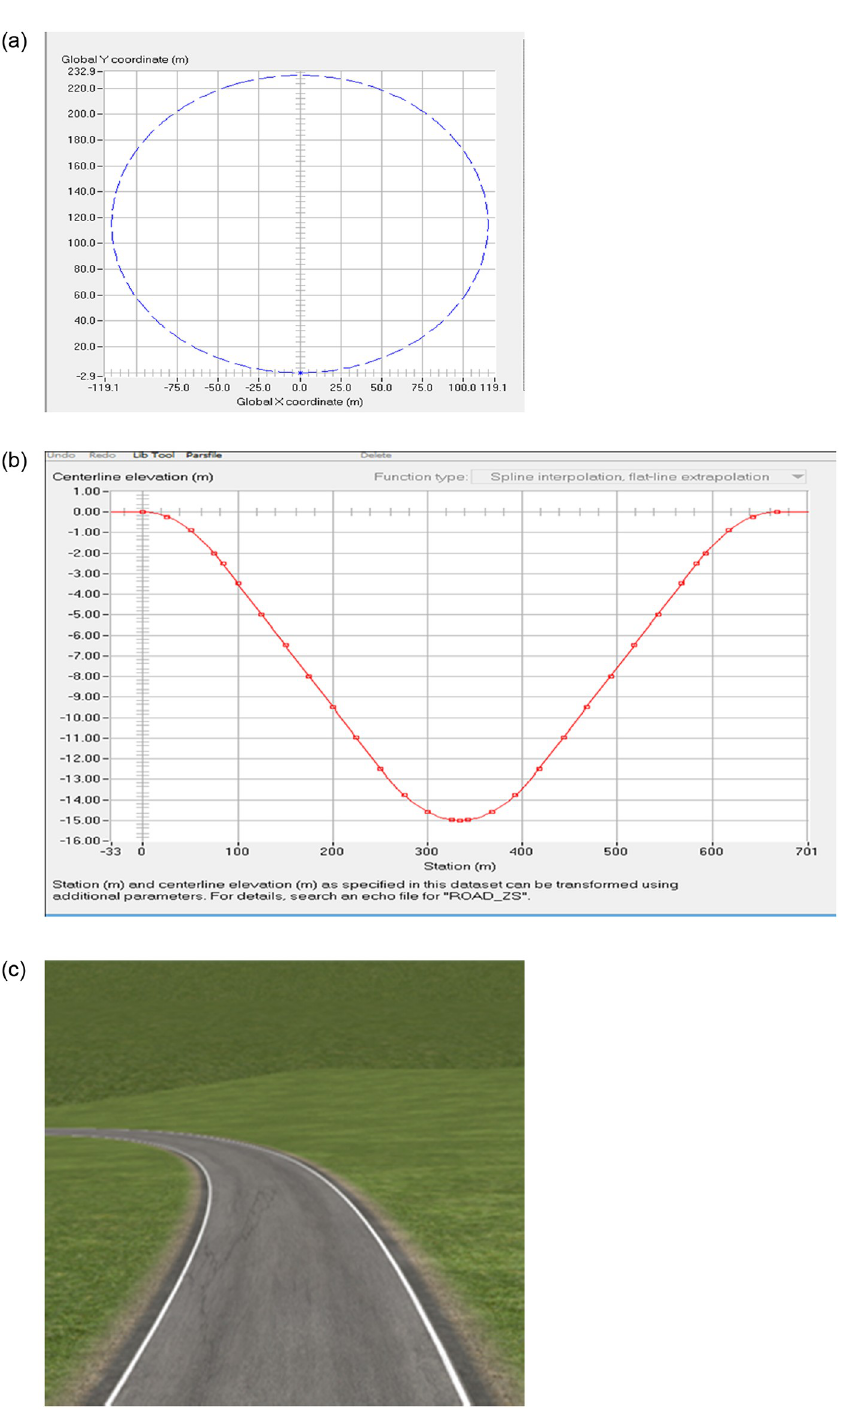
Fig 4. Three-dimensional road model of slope-curve section of TruckSim.